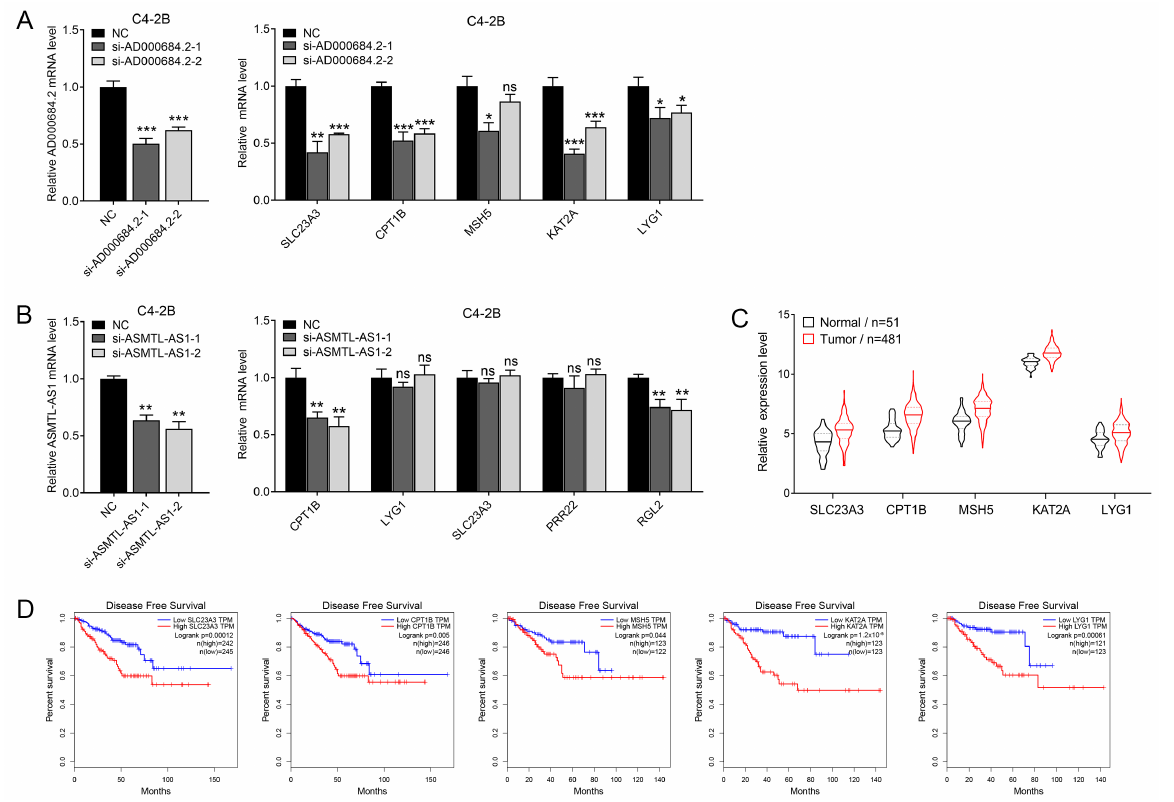
Figure 3. AD000684.2 positively regulates the expression of positively correlated genes: ( A ) C4-2B cells were transfected with siRNA to specifically knock down the expression of AD000684.2, and then the mRNA levels of AD000684.2 and positively related genes were simultaneously detected by RT-qPCR ( n = 3; data are presented as the mean ± SD; * p < 0.05; ** p < 0.01; *** p < 0.001; ns, not significant); ( B ) the siRNAs specifically targeting ASMTL-AS1 were transfected into C4-2B cells, and then RT–qPCR was used to simultaneously detect the mRNA levels of ASMTL-AS1 and positively correlated genes ( n = 3; data are presented as the mean ± SD; ** p < 0.01; ns, not significant); ( C ) analysis of the expression levels of SLC23A3, CPT1B, MSH5, KAT2A, and LYG1 in PCa tissues and normal tissues in the TCGA database; ( D ) Kaplan–Meier curves of disease-free survival (RFS) in PCa patients with high or low expression of SLC23A3, CPT1B, MSH5, KAT2A, and LYG1. According to the analysis of the expression of AD000684.2 positively regulated genes (SLC23A3, CPT1B, MSH5, KAT2A, and LYG1) of PCa in the TCGA database, these five genes were highly expressed in PCa tissue (Figure 3C), and survival curve analysis showed that these five genes had a certain prognostic value (Figure